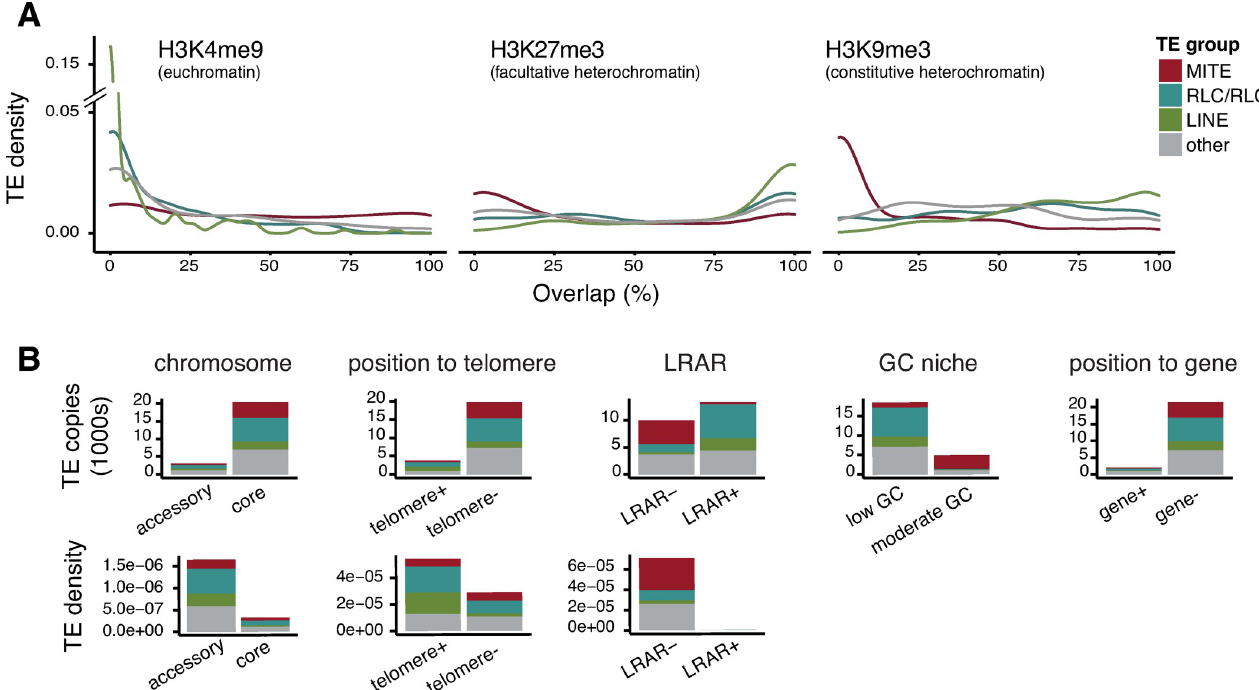
Fig 2. Characteristics of TE niches across the genome : (A) Proportional overlap of H3K27me2, H3K4me9 and H3K9me3 histone methylation marks with TE niches in the reference genome IPO323. Colors indicate the group of TE. (B) TE copy numbers between core and accessory chromosomes (copy number and density): in and outside the subtelomeric region (copies and density); into large RIP affected regions (LRAR; copy and density); into niches with a moderate ( � 50%) or low ( < 50%) GC content; overlapping regions annotated as genes.